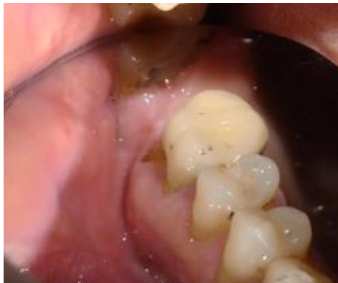
Figure 1. The preoperative site shows the absence of 1.7 and the crown on 1.6 (with abscess).